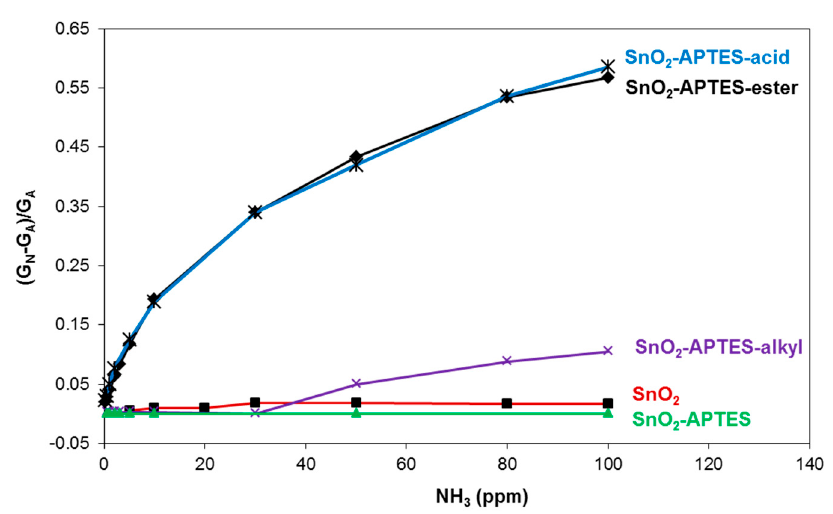
Figure 2. Relative response of SnO 2 , SnO 2 -APTES, SnO 2 -APTES-alkyl, SnO 2 -APTES-acid and SnO 2 -APTES-ester sensors versus ammonia concentrations in 5%RH air at 25